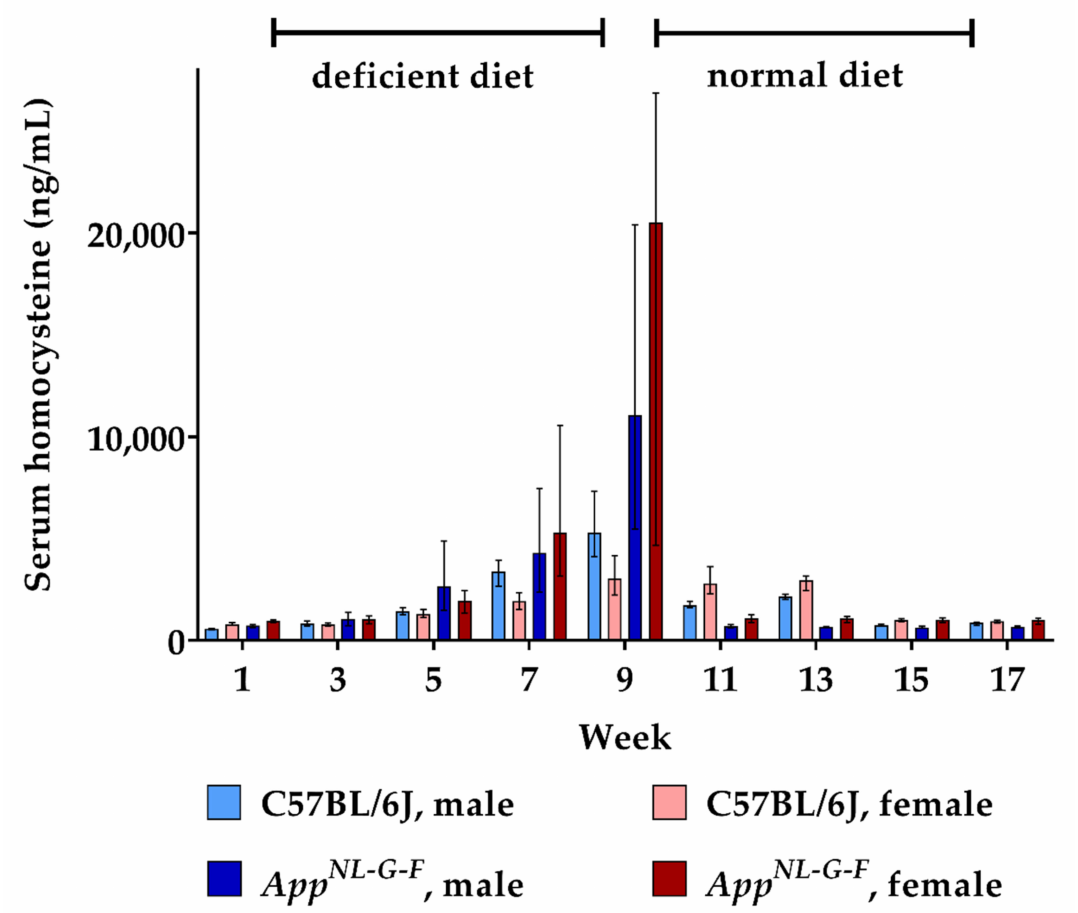
Figure 1. Serum homocysteine levels in C57BL/6J wild type and App NL-G-F knock-in mice, data are depicted for males and females separately for experimental week 1-17: baseline measurement (w. 1), diet deficient in vitamin B6, B12 and folate (for 8 w.), balanced normal chow (for 8 w.); all serum samples were analyzed using a combination of liquid chromatography with tandem mass spectrometry and statistically tested non-parametrically using the Kruskal-Wallis test; data are presented as median ± interquartile range (IQR); extreme outliers beyond 3xIQR have been